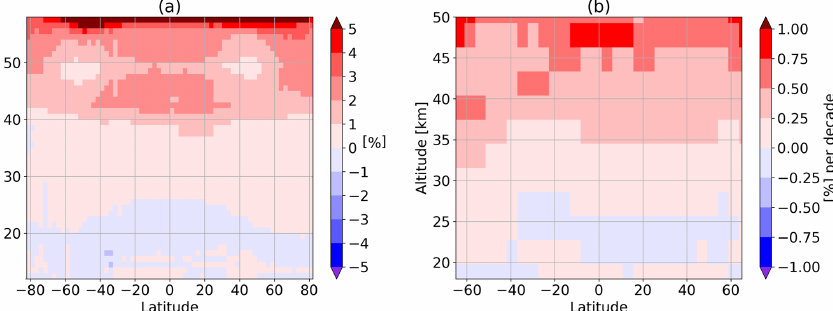
Figure A1. (a) Relative differences between MLS ozone profiles zonally averaged over 2016 in case the pressure profiles for the conversion from VMR vs. pressure to number density vs. altitude are taken from ECMWF or from MERRA-2 reanalysis. (b) Effect of using MERRA-2 pressure profiles instead of ECMWF to convert MLS in terms of ozone trends over